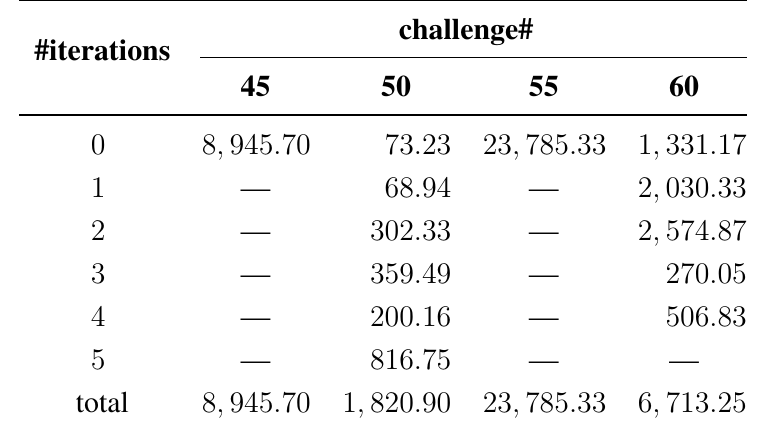
Table 5. Computational time (s) for challenge numbers 45, 50, 55 and 60 under our current best formulation.